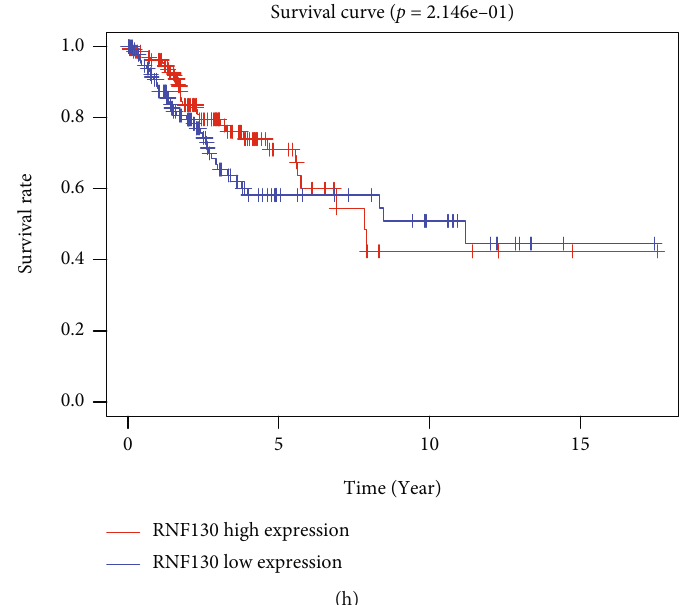
Figure 3: Screening of prognostic model factors. (a) Univariate Cox regression analysis screened out 4 prognostic related genes. (b) Trajectory changes of 4 genes. (c) Con fi dence interval for each λ value. (d) Multivariate Cox regression analysis. (e – h) K-M survival curves of 4 genes with independent prognostic